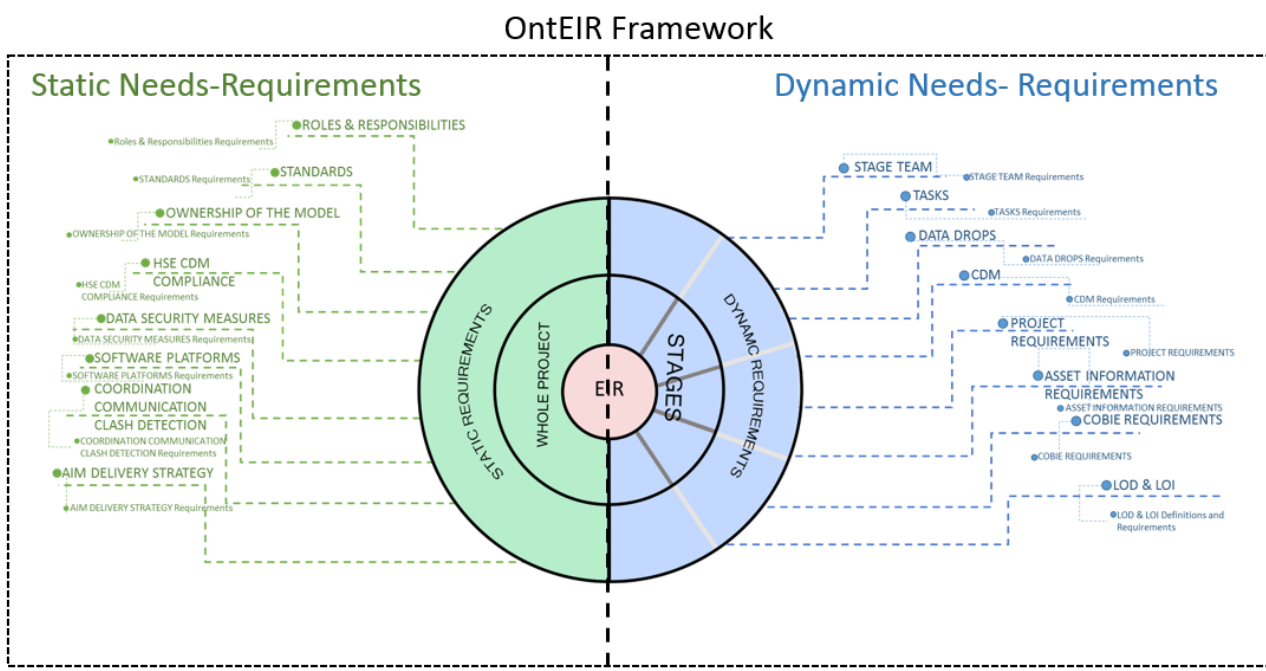
Figure 13. OntEIR Framework — Categorisation of static and dynamic needs/requirements.